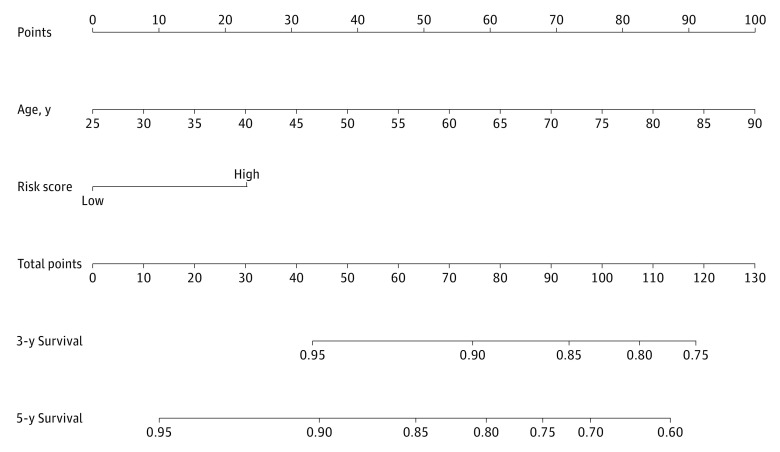
Nomogram for Predicting Probabilities of Overall Survival in Patients With Breast Cancer